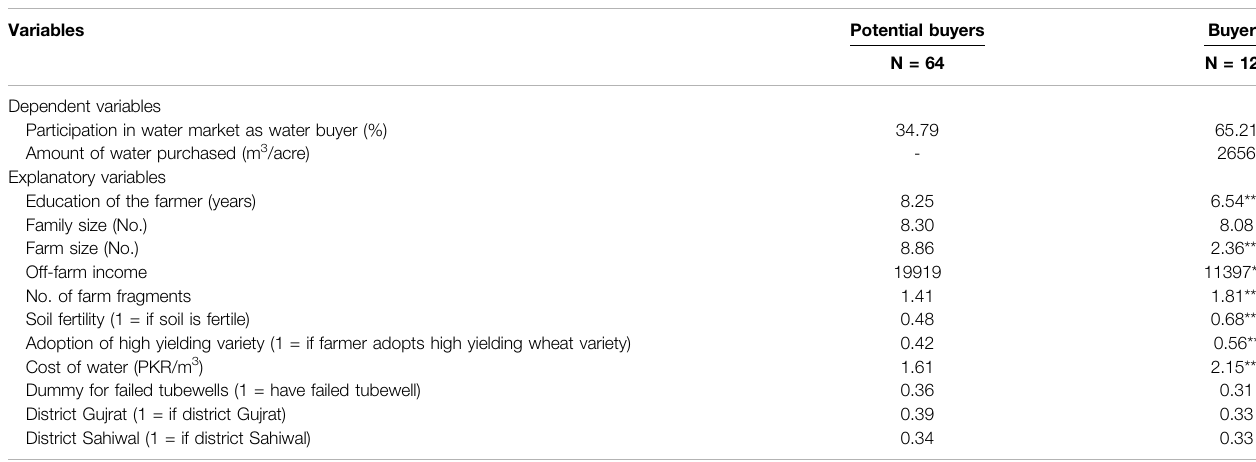
TABLE 2 | Summary statistics of variables used in the econometric model on per farm basis of water buyers.